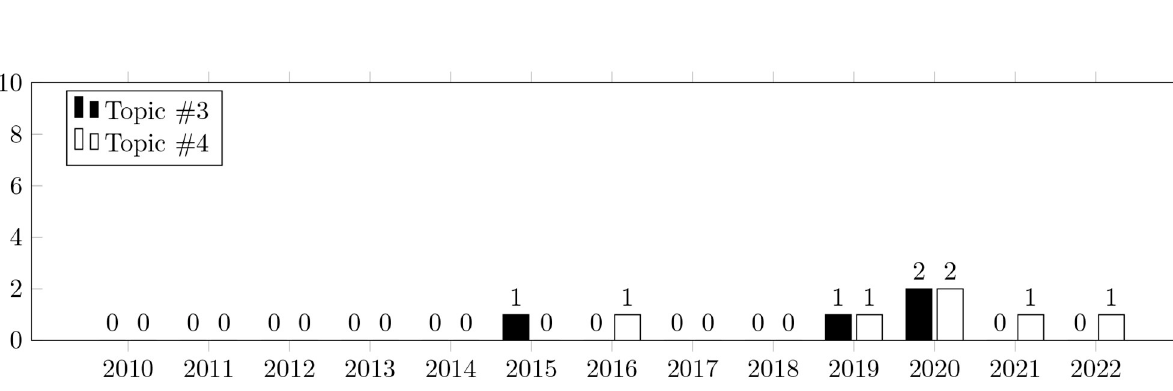
Fig 6. Topics distribution by year of publication. The bars show the number of papers related to the key topic published in a particular year. Black bars show the number of papers related to “issue prioritization”. White bars show the number of papers related to “pull request prioritization”.